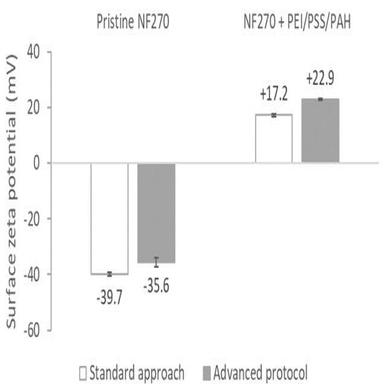
Surface zeta potential of the NF270 membrane calculated with the standard approach and the advanced protocol; Solution: 0.001 M KCl at pH 5.60 ± 0.05.